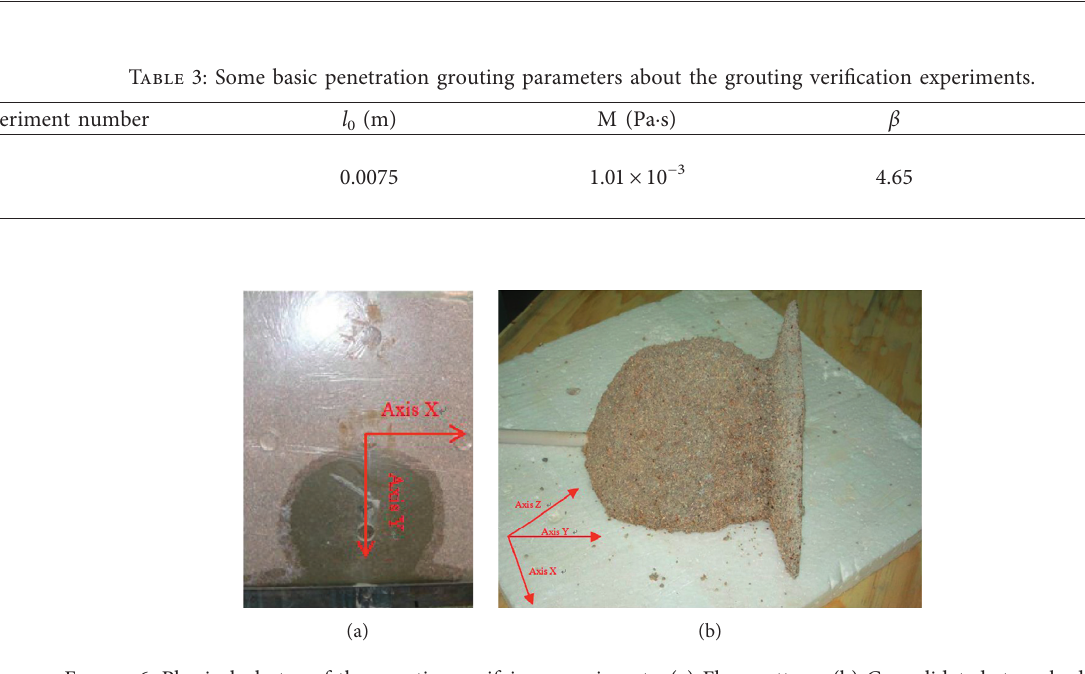
Figure 6: Physical photos of the grouting verifying experiments. (a) Flow pattern. (b) Consolidated stone body. Table 4: Analysis and comparison of the diffusion radius on x- , y- , and z -axis directions of grouting stone body. Diffusion radius size of grouted and consolidated stone body Experiment